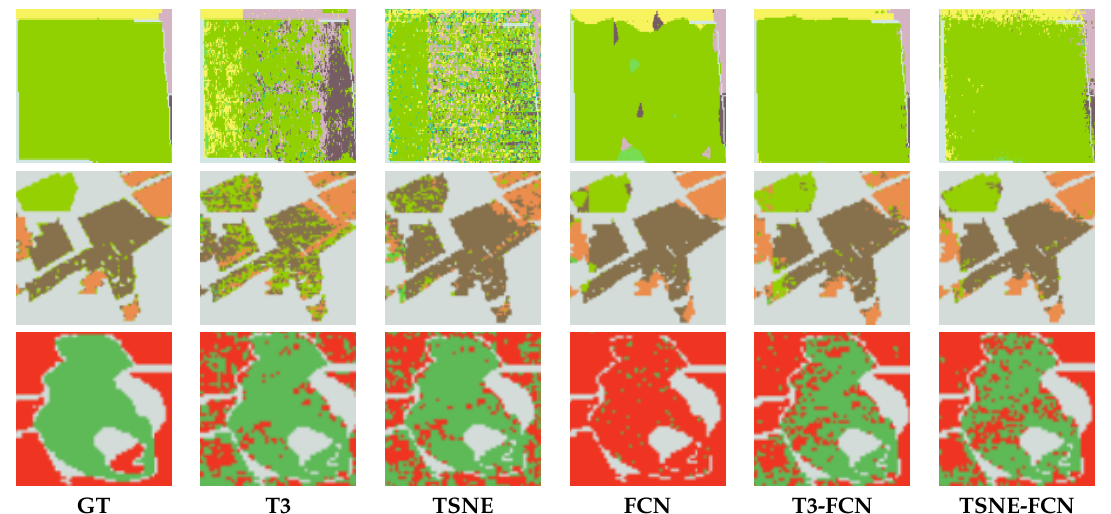
Figure 13. Three rows are magnified classification areas of Flevoland, Foulum and San Francisco datasets in order, the magnified areas are marked ‘ black ’ in their corresponding GT (see Figures 10–12). Best viewed on